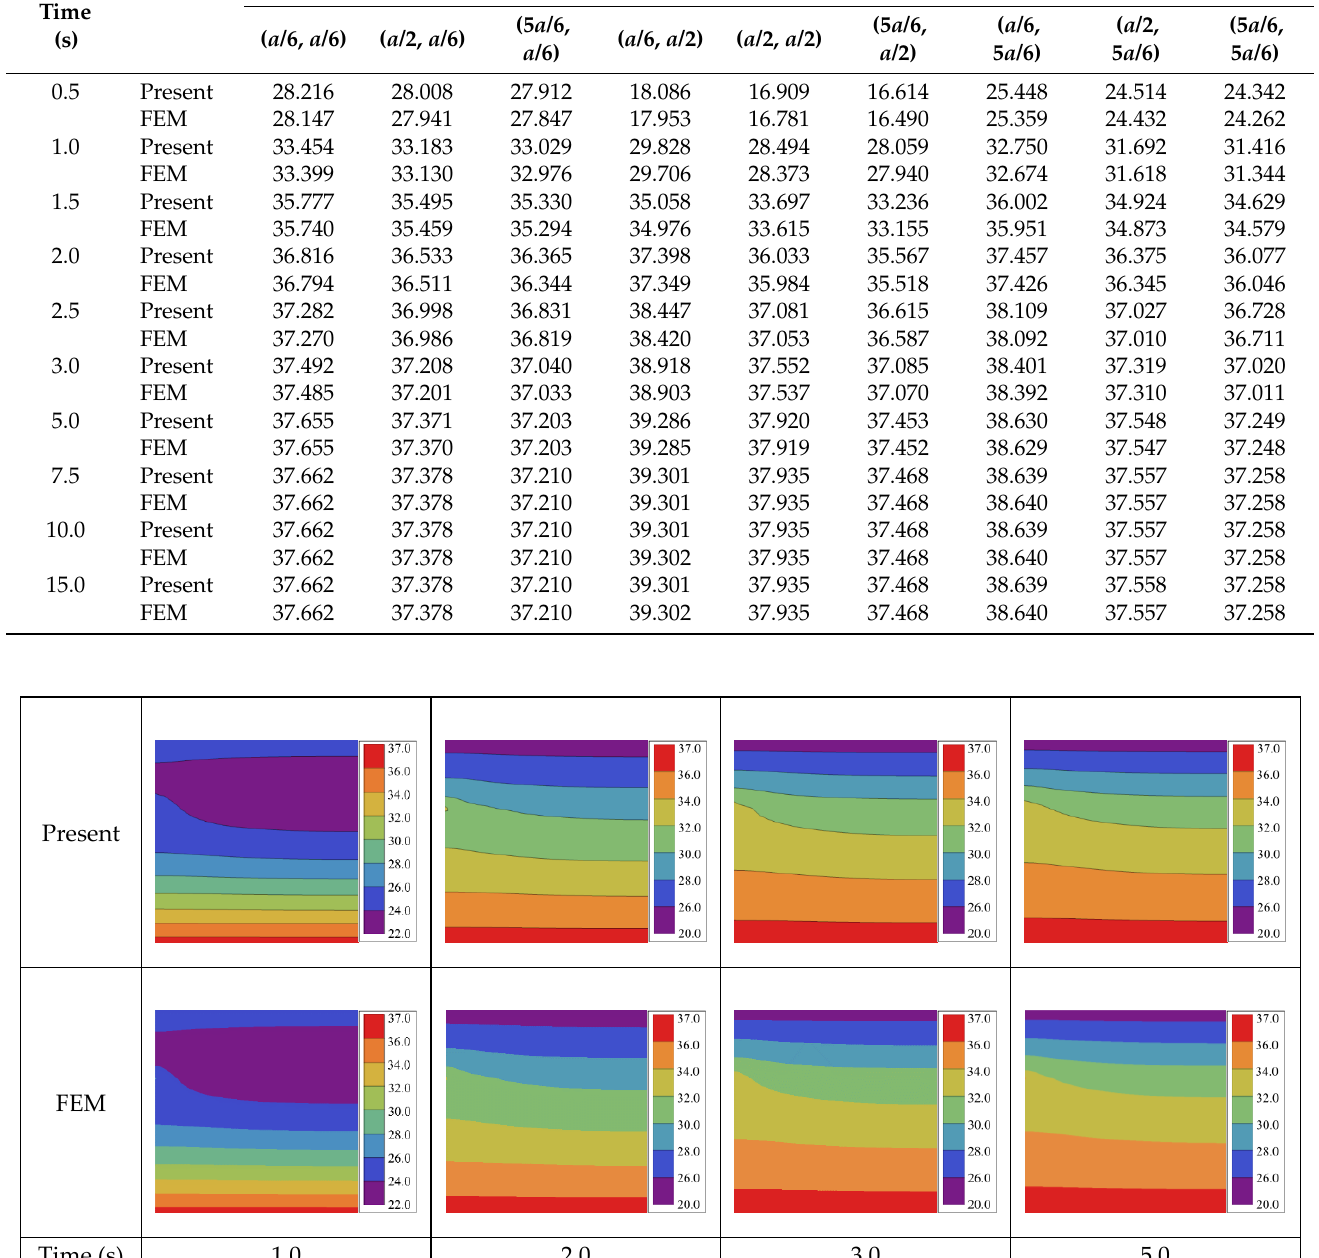
Figure 5. Time-dependent temperatures for Case 1 at ( a /2, a /2), with the inset showing the temperature distribution under steady state.